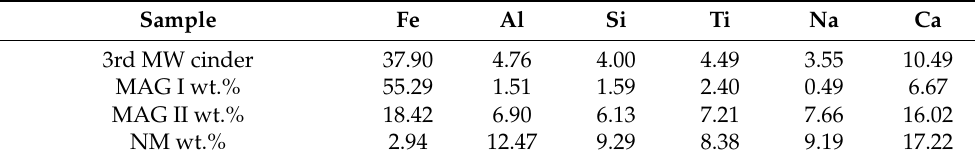
Table 8. Chemical analysis of the cinder (3rd MW) and the three fractions (MAG I, MAG II, and NM) after the magnetic separation.